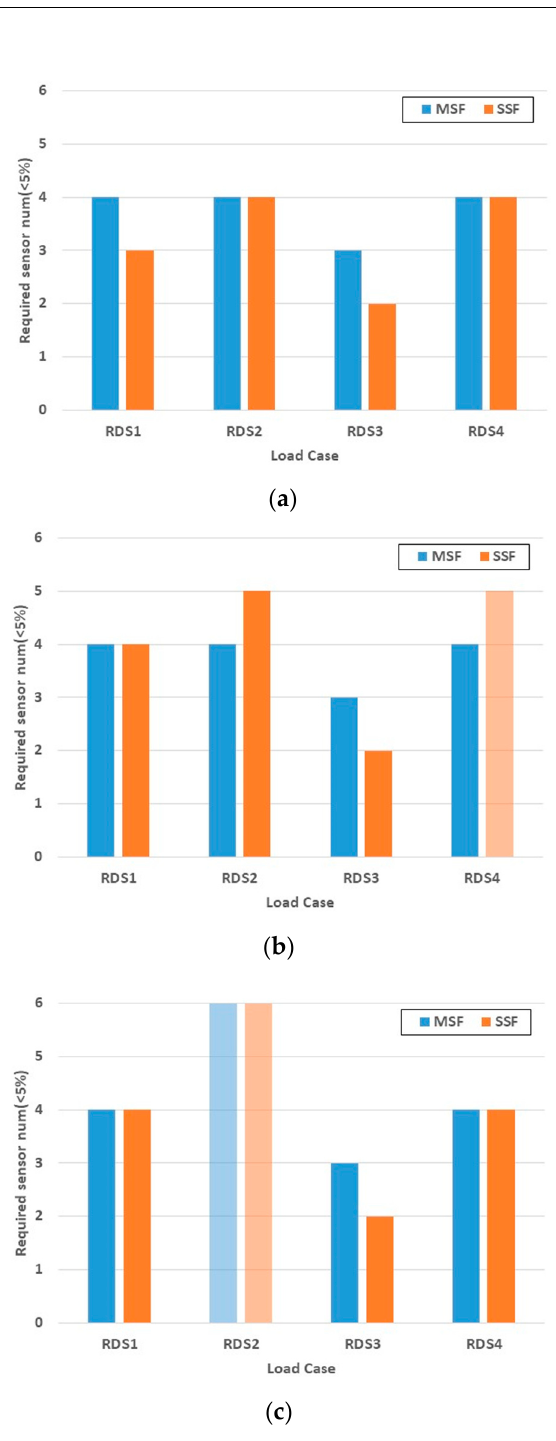
Figure 10. Required number of sensors (NMAPE < 5%): ( a ) displacement; ( b ) slope; ( c ) strain.